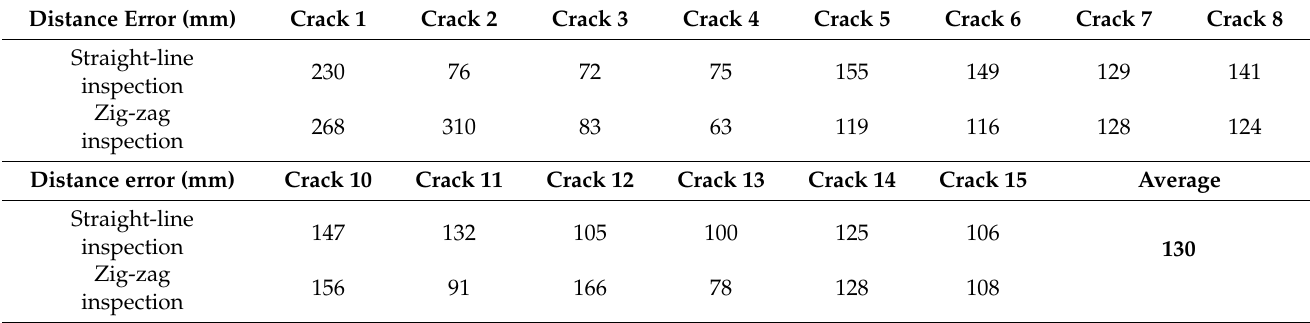
Table 9. Localization accuracy assessment—distance errors in 3D